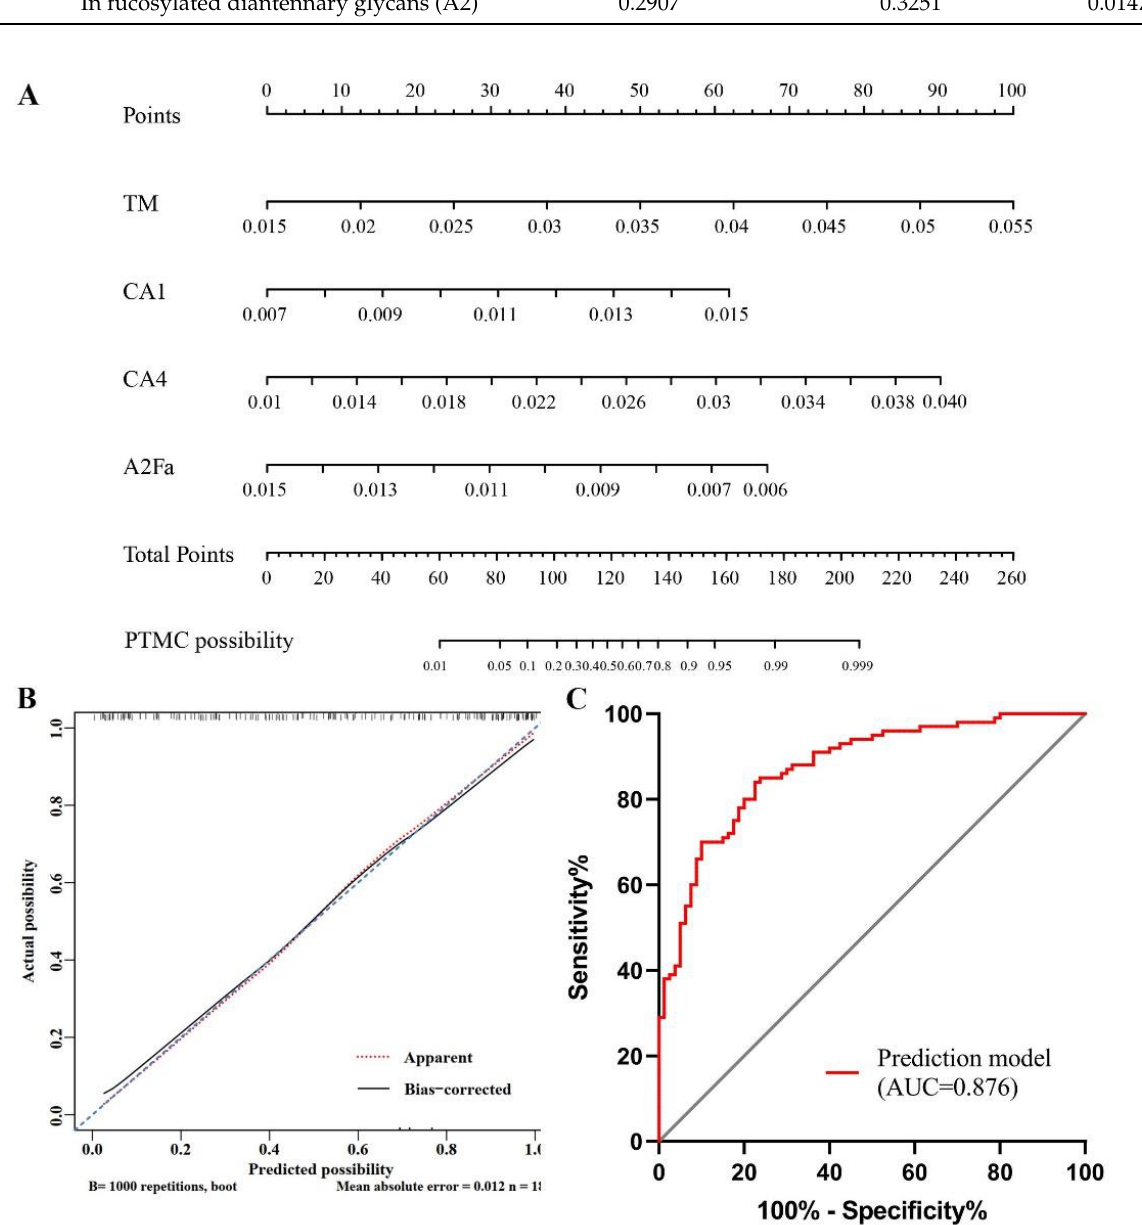
Figure 4. The binomial logistic regression model constructed from glycans for the diagnosis of PTMC. ( A ) The visualized nomogram of the logistic regression model; ( B ) Calibration curve of the diagnosis nomogram. The 45 ◦ dashed line represents the ideal predictions. The solid line shows a bias-corrected curve. The dotted line shows the nomogram probability; ( C ) ROC curve of the nomogram for the diagnosis of PTMC. PTMC, papillary thyroid microcarcinoma; ROC, receive operating characteristic; AUC, area under the curve.